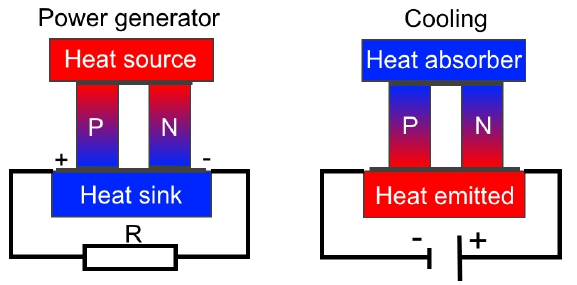
Figure 3. Thermoelectric power generator and cooling